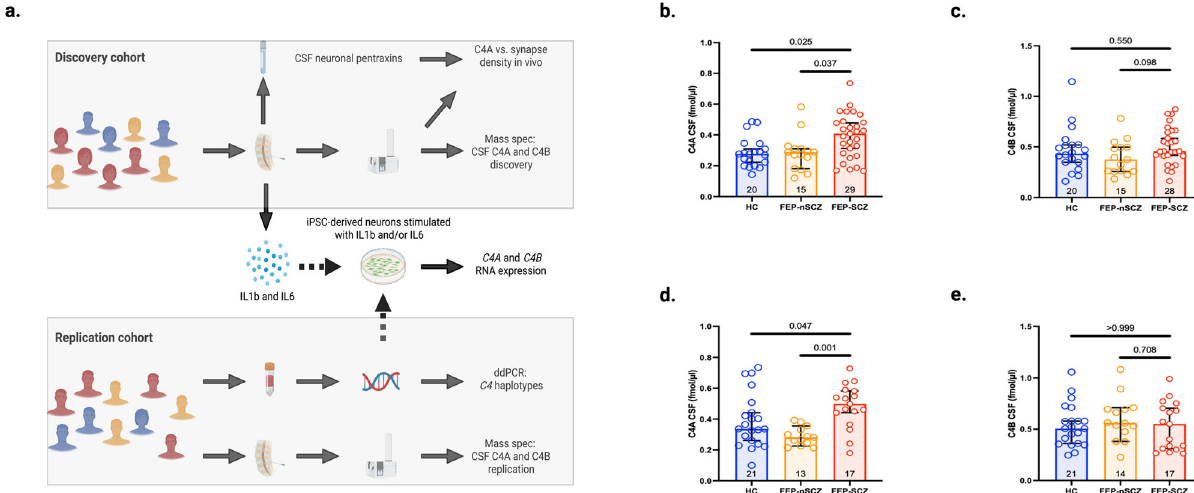
Fig. 1 | Cerebrospinal fl uid levels of C4A are increased in patients with fi rst- episode psychosis who develop schizophrenia. a Overview of the study design. b In the discovery cohort (KaSP), patients with fi rst-episode psychosis (FEP) who developed schizophrenia (FEP-SCZ; n =29) displayed signi fi cantly higher cere- brospinal fl uid (CSF) C4A concentrations as compared to healthy controls (HCs; n =20) or patients with FEPwho didnot develop SCZ (FEP-nSCZ; n =15)(HCs: 0.28 fmol/ul; 95% con fi dence interval [CI]=0.24 – 0.33, FEP-nSCZ: 0.29 fmol/ul; CI=0.22 – 0.35, FEP-SCZ: 0.41; CI=0.34 – 0.45, adjusted P [FEP-SCZ vs.